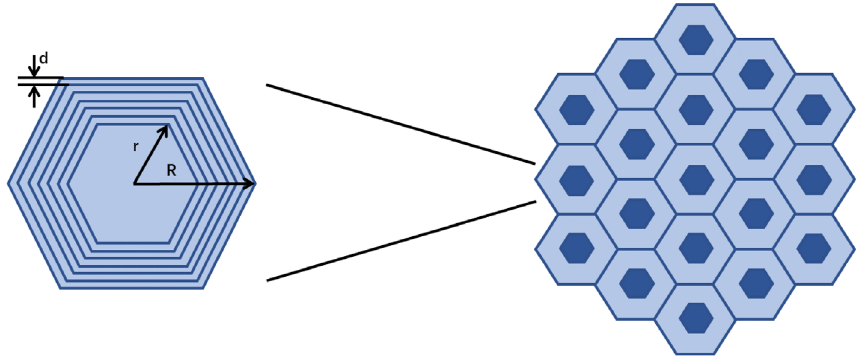
Fig. 10. Schematic diagram of hexagonal